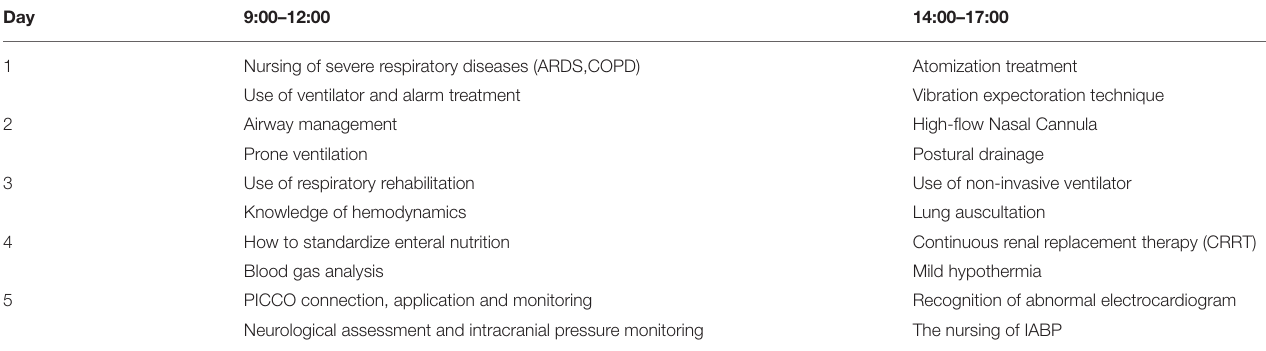
TABLE 1 | Theoretical course schedule (one